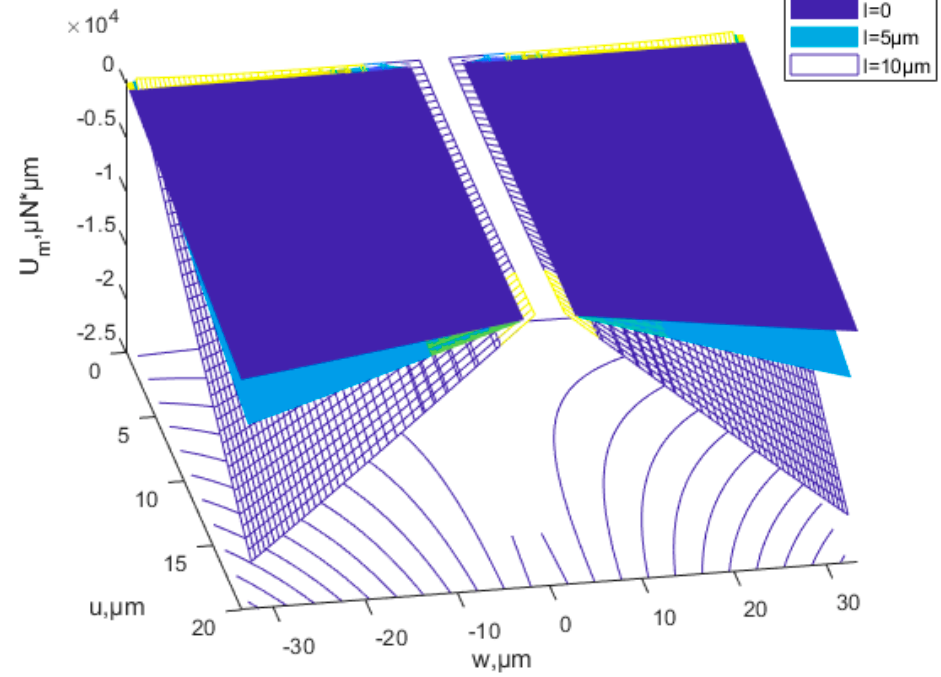
Figure 8. Effects of the scale parameters on membrane energy of a thin Cu plate.